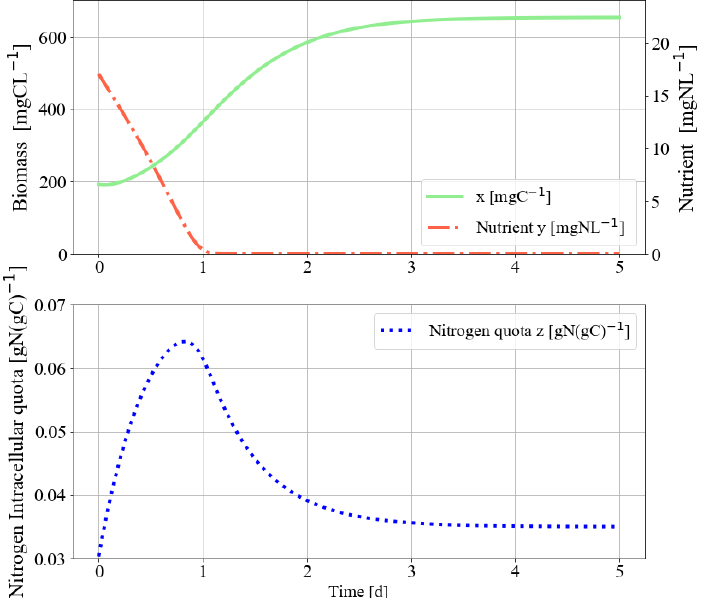
Figure 7. Batch mode simulation of biomass x , limiting nutrient y , and intracellular quota z concentrations vs. cultivation time under a constant light intensity of 150 µ molm − 2 s − 1 , show- ing the final biomass production at nutrient depletion. The initial conditions correspond to x 0 = 192.332 mgCL − 1 , y = 17.03 mgNL − 1 , and z 0 = 0.0303 mgN ( mgC ) − 1 . The model input param- eters for simulation are ρ m = 0.0901 mgN ( mgC ) − 1 d − 1 , k s = 1.6499 mgNL − 1 , µ m = 1.9054 d − 1 , and zc 0 = 0.0350 mgN ( mgC ) − 1 . Taken from